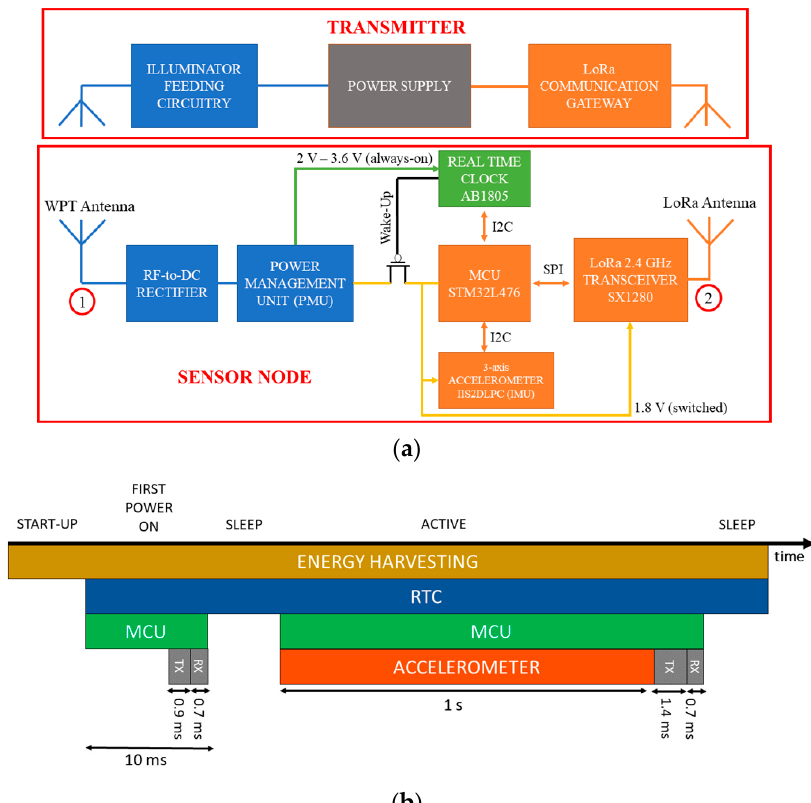
Figure 3. ( a ) Block diagram of the overall system, comprising of the transmitting part (illuminator and LoRa communication gateway), and the wireless sensor node; ( b ) operational modes of the sensor node; colors show which components are active in the different phases.